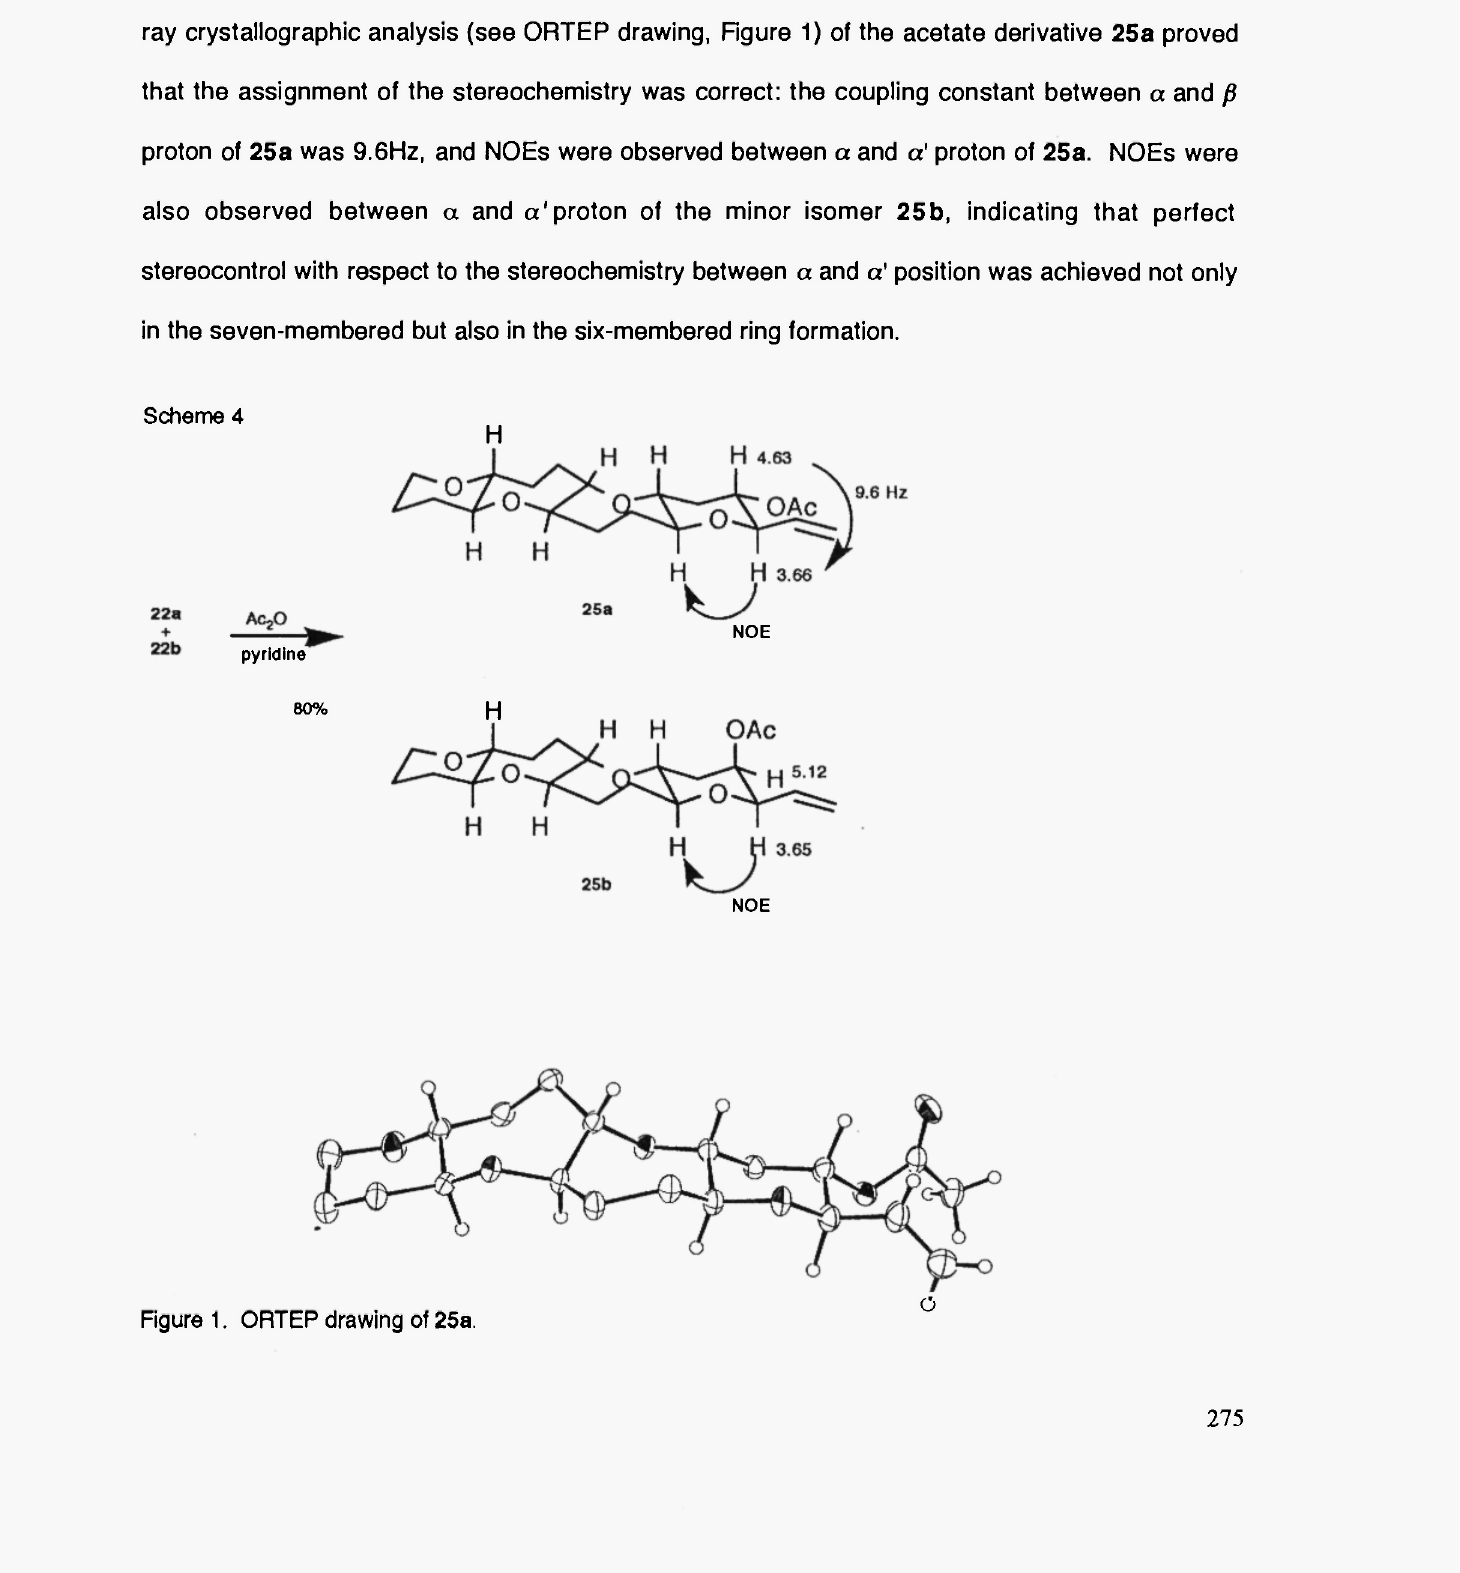
Figure 1. ORTEP drawing of